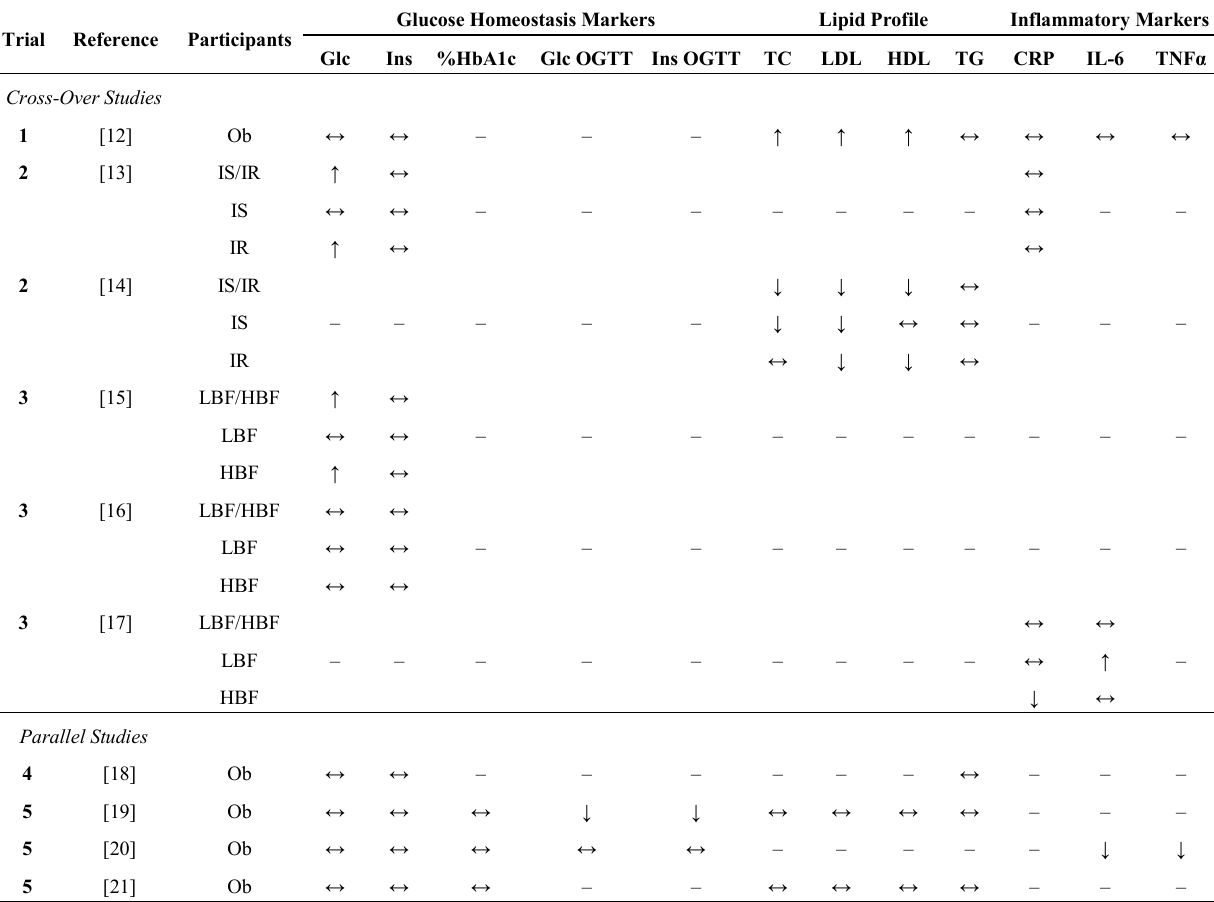
Table 3. Effect of low versus high GI/GL diets on selected glucose homeostasis markers, lipid profile and inflammatory